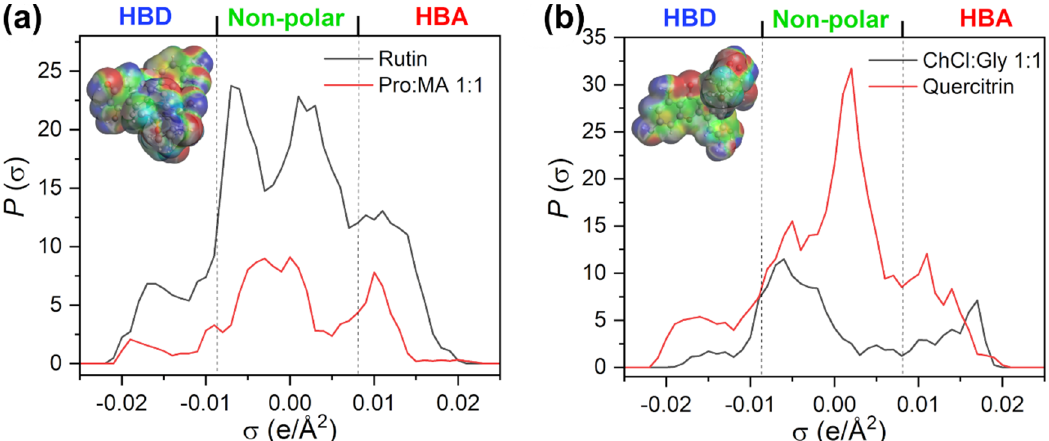
Figure 3. ( a ) The σ‐ profiles of a) rutin and NADES1 (L ‐ proline: maleic acid 1:1); ( b ) quercitrin and NADES5 (choline chloride: glycerol 1:1). The surface charge density of a solute is shown in the up ‐ per ‐ left part of the